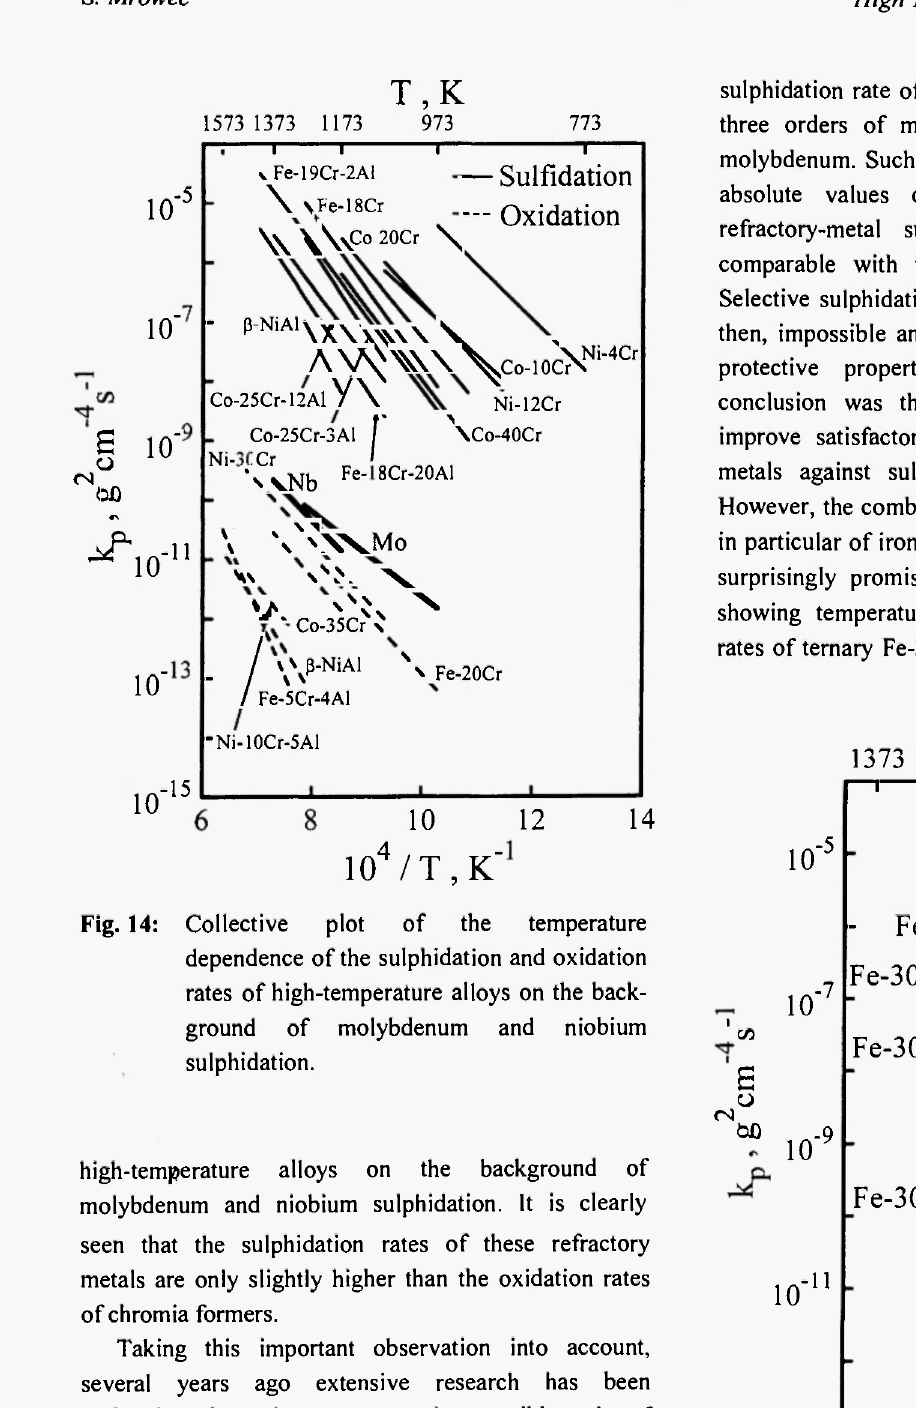
Fig. 14: Collective plot of the temperature dependence of the sulphidation and oxidation rates of high-temperature alloys on the back- ground of molybdenum and niobium sulphidation.